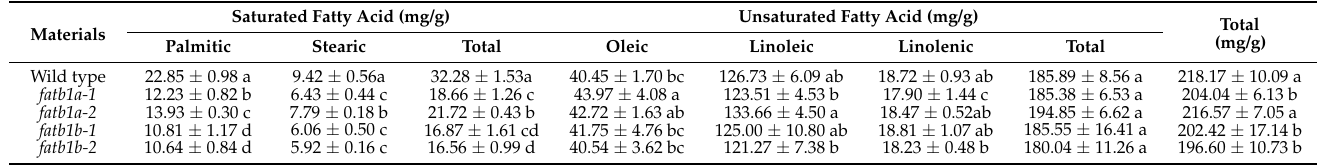
Table 2. Seed fatty acid content of the different materials (mg/g).